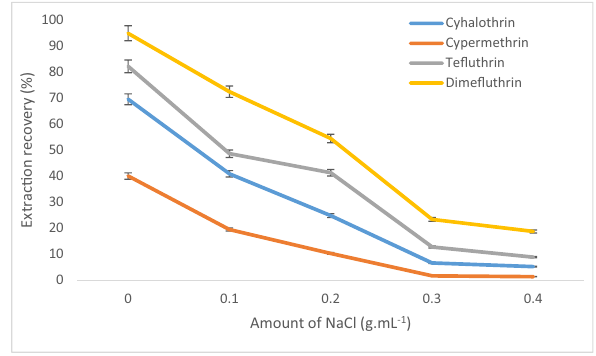
Figure 5: E ff ect of ionic strength on the e ffi ciency of extraction ( ex - traction conditions: 100 µL of 100 ng L − 1 of each analyte; extraction time: 180 min; stirring speed: 700 rpm; sample volume: 20 mL; temperature: 40°C; pH: 7 ) .